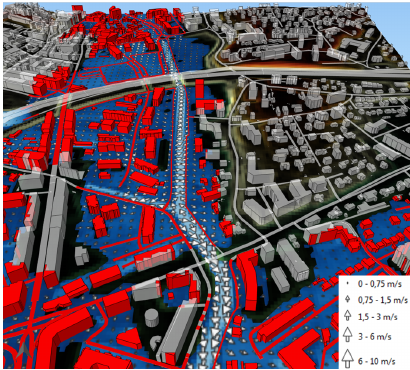
Figure 6. Simulation data interacting with 3D city model. In red, parts of buildings being impacted by simulated water